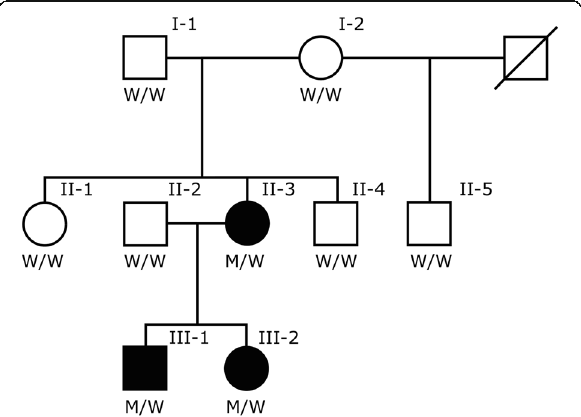
Fig. 2 The three-generation family. Shown are genotypes of the COPA mutation (W: wild-type allele, M: mutated allele). Blackened symbols denote affected individuals, unblackened symbols denote unaffected individuals, and the slashed line denotes deceased. The genotypes of the siblings of the index case (II-3) were obtained with Sanger sequencing and the other six family members were whole-genome